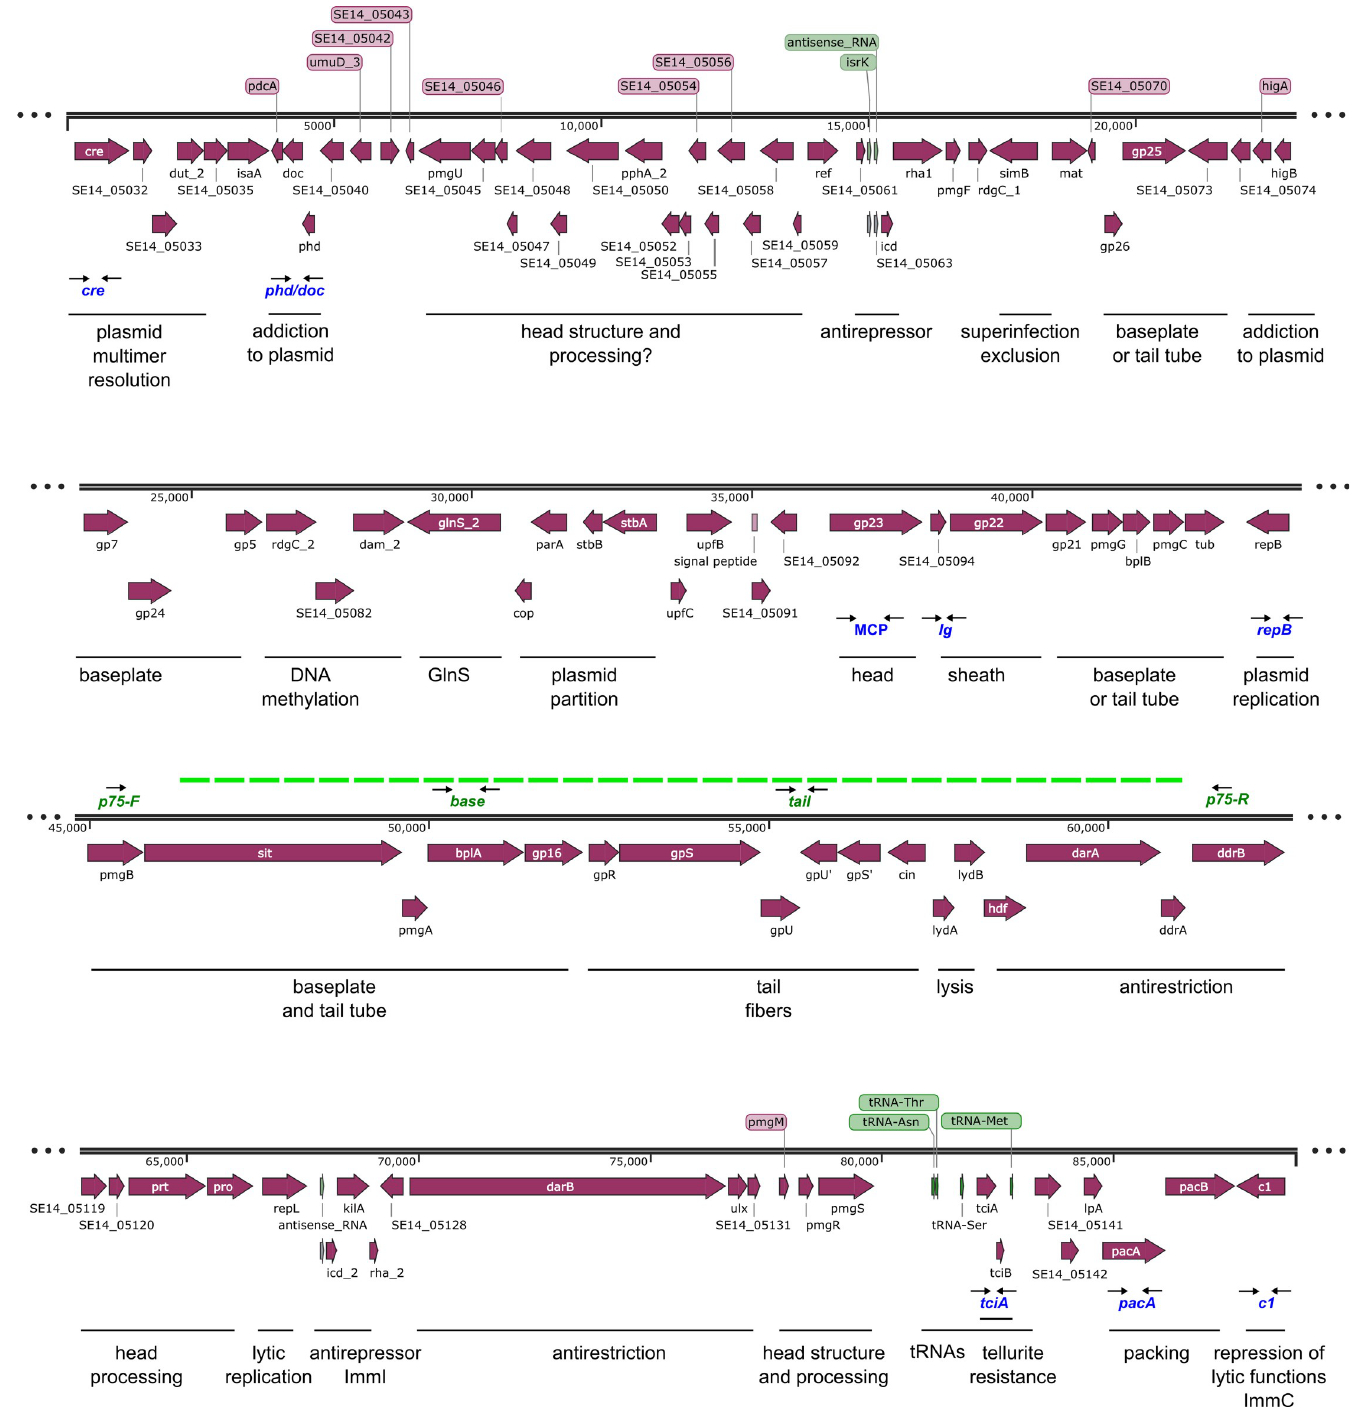
Fig 1. Linear representation of the pYU39_89 plasmid-phage, inferred functional modules and regions used for the PCR screening. The pYU39_89 sequence (CP011430) (Calva, et al. 2015) was reannotated using the nomenclature for homologous genes in the P1 genome (Lobocka, et al. 2004) and the description of the D6 genome (Gilcrease and Casjens 2018). The names for the open reading frames are indicated inside, below or above the wide arrows. Inferred functional modules are indicated below and grouped by a solid line. The eight regions used for PCR detection are indicated in blue below as two thin arrows. The green dotted line indicates the region absent in the p75 plasmid-phage, and under the line are the three primer pairs used to distinguish the p89 and p75 variants. The predicted gene functions are listed in S1 Table.